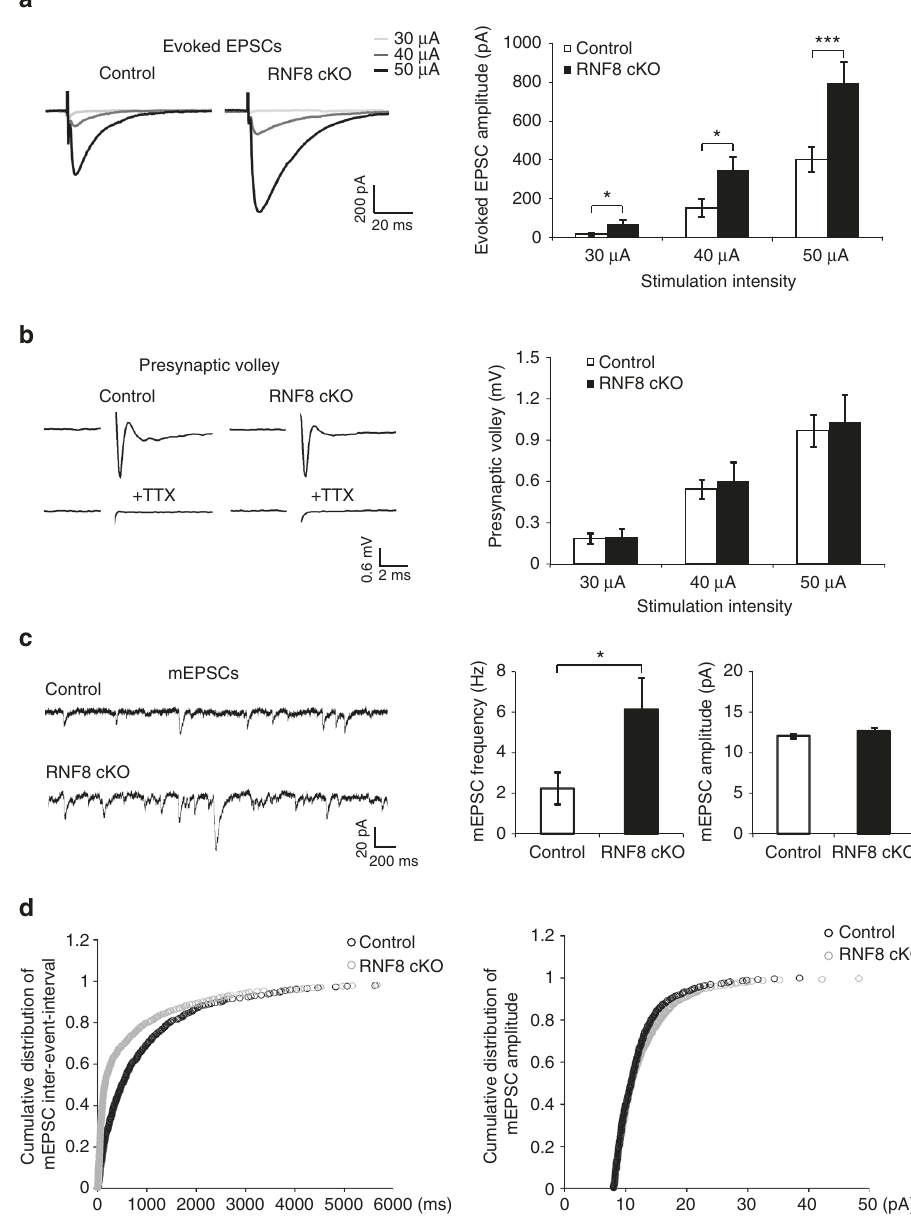
Fig. 2 RNF8 suppresses granule neuron to Purkinje cell neurotransmission in the cerebellum. a Acute sagittal cerebellar slices from P20 – 25 RNF8 cKO and control mice were subjected to electrophysiological analyses. Evoked excitatory postsynaptic currents (EPSCs) were recorded in Purkinje neurons in response to stimulation of parallel fi bers with increasing intensity (30, 40, and 50 μ A). Representative current traces (left) and quanti fi cation of the amplitude of evoked EPSCs (right) are shown. The amplitude of evoked EPSCs in Purkinje neurons was increased in RNF8 cKO mice compared to control mice (* p < 0.05 at 30 and 40 μ A, *** p < 0.005 at 50 μ A, ANOVA followed by Fisher ’ s PLSD post hoc test, n = 14 – 15 neurons, four mice). b Acute coronal cerebellar slices were prepared as in ( a ), and parallel fi ber axons were stimulated at sites 400 μ m away from an extracellular recording electrode. A representative trace of the stimulus-evoked presynaptic waveform before and after the application of tetrodotoxin is shown (left). The stimulus artifact was removed for clarity. On the right, quanti fi cation of presynaptic volley amplitude is shown. Conditional knockout of RNF8 had little or no effect on the presynaptic volley amplitude. c , d Acute sagittal cerebellar slices were prepared as in ( a ) and Purkinje cell miniature EPSCs (mEPSCs) were recorded. Representative traces of mEPSCs from RNF8 cKO and control mice are shown ( c , left). Quanti fi cation of the mean ( c , right) and cumulative distribution ( d ) of the mEPSC frequency and amplitude are shown. The frequency of mEPSCs was increased in RNF8 cKO mice compared to control mice (* p < 0.05, t test, n = 18 – 20 neurons, three mice). Conditional knockout of RNF8 had little or no effect on the amplitude of mEPSCs in Purkinje contrast, the number of parallel fi ber presynaptic boutons was 100 μ m; RNF8 cKO: 5.94 ± 0.243 boutons/100 μ m; n = 4 – 5 mice; increased at P17 upon conditional knockout of RNF8 (control: mean ± s.e.m.; p = 0.003, t test) (Fig. 1c). 4.07 ± 0.065 boutons/100 μ m; RNF8 cKO: 5.16 ± 0.051 boutons/ In corroborating electron microscopy (EM) analyses, the 100 μ m; n = 3 mice; mean ± s.e.m.; p = 8.27E − 05, t test), and this number of parallel fi ber/Purkinje cell synapses was signi fi cantly difference was maintained at P21 (control: 4.28 ± 0.283 boutons/ increased in RNF8 conditional knockout mice compared to